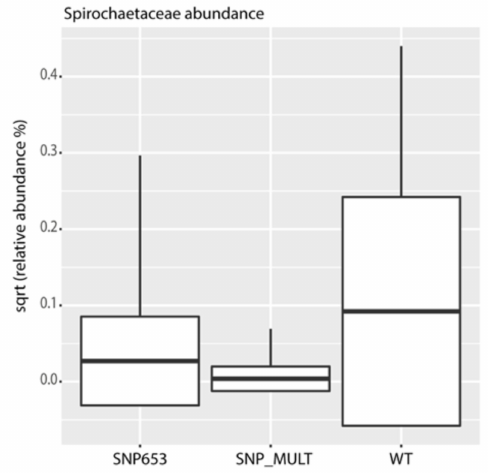
Figure 9. Square-root-normalized relative abundance of Spirochaetaceae , an indicator taxon for Nrf2 genotype. WT = wild-type (without SNP); SNP_MULT = Nrf2 promoter SNPs rs35352124, rs6706649 and rs6721961 or 3SNP. (ANOVA, p = 0.0006, Tukey’s post hoc test, WT-SNP653: p = 0.002, WT- SNP_MULT: p = 0.0004, SNP_MULT-SNP653: p =